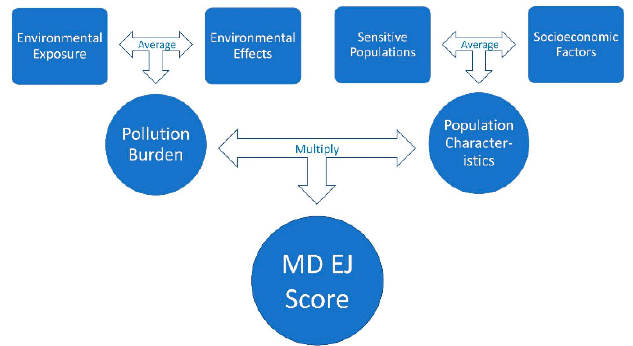
Figure 1. Overview of MD EJ (Maryland Environmental Justice) Scoring Process. The Environmental Exposure and the Environmental Effects Scores are averaged to calculate the Pollution Burden, and the Sensitive Populations and Socioeconomic Factors are averaged to create the Population Characteristics Score. The Pollution Burden and Population Characteristics are then multiplied to calculate the final MD EJ Score.